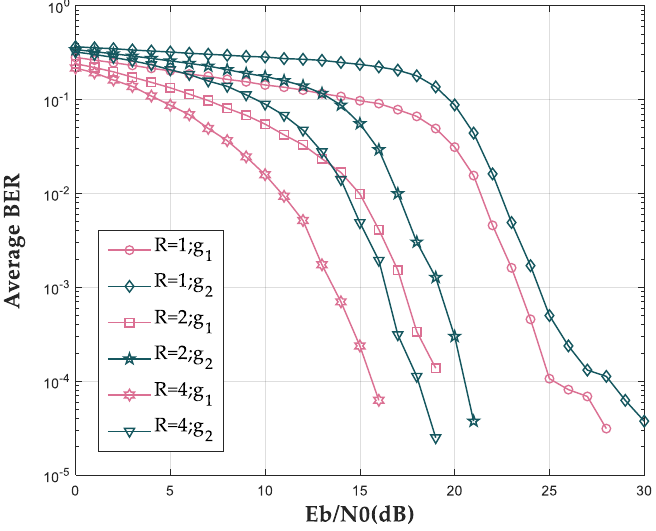
Figure 16. Average BER curves of SP − MPA in MIMO system.